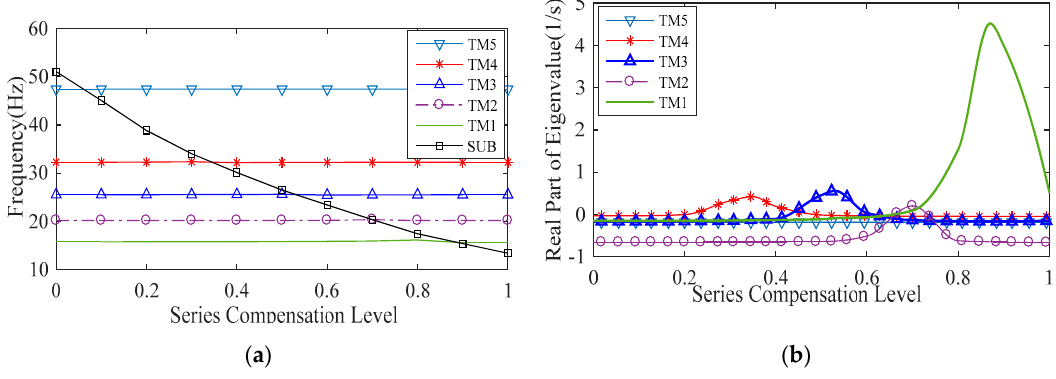
Figure 4. Influence of series compensation level on SSR characteristics. ( a ) The imaginary parts of eigenvalues. ( b ) The real parts of eigenvalues.